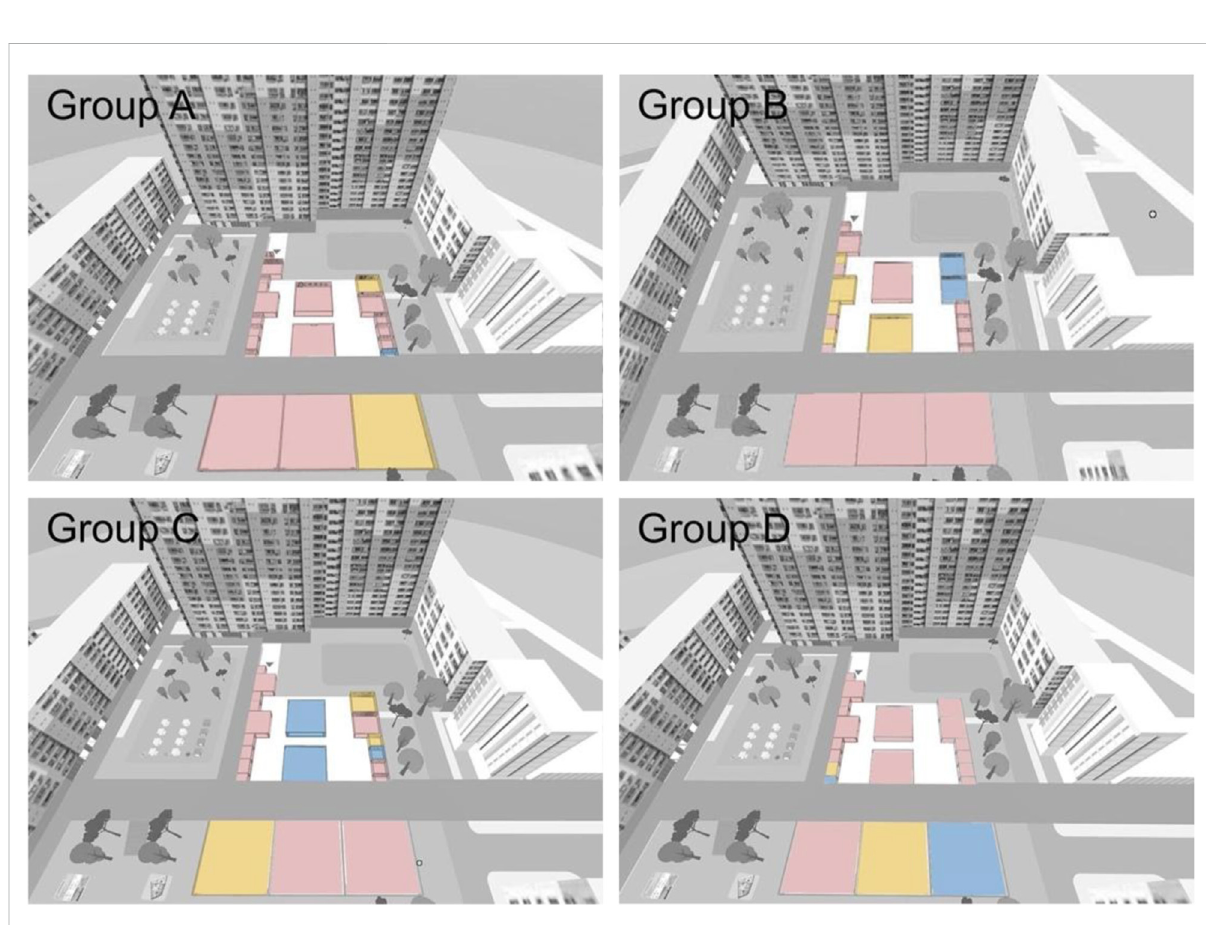
FIGURE 12 Game results from each team. On average, basic needs were apportioned 68.2%, community needs 11.8%, and lifestyle and Interests